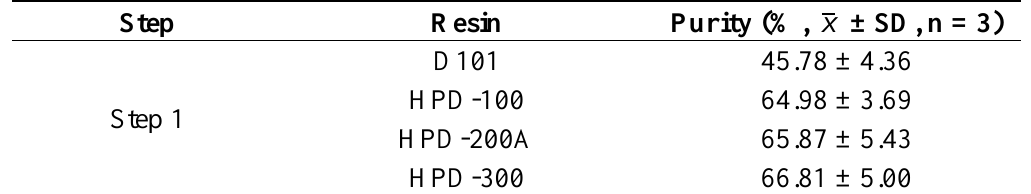
Table 1. Purities of ASD in 60% ethanol desorption solutions in the dynamic desorption